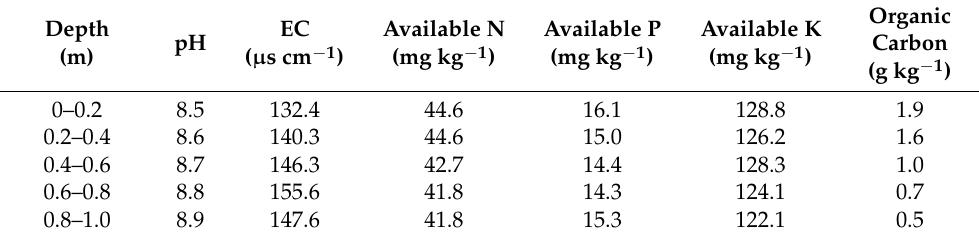
Table 3. Soil chemical properties of the experimental site.